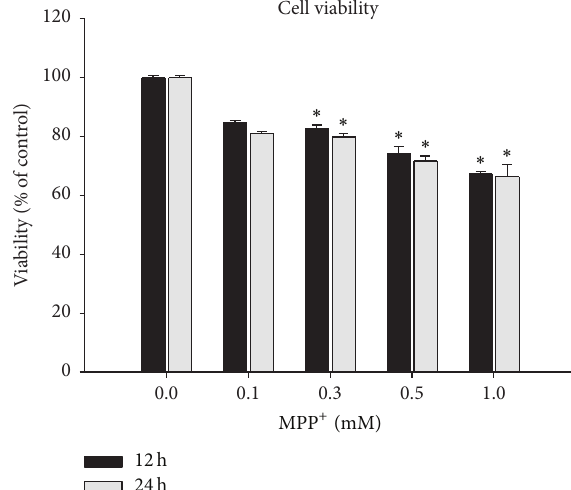
Figure 1: Comparisons of cell viability between control and MPP + - exposed BV-2 cells. MPP + was applied to the BV-2 cells at four concentrations (0.1 mM, 0.3 mM, 0.5 mM, and 1mM) and the incubation times were 12 hours and 24 hours . Note that there was no significant difference in cell viability between 0.1mM MPP + and control groups and there was a significant difference in cell viability between 0.3 mM MPP + and the control, between 0.5 mM MPP + and the control, and between 1mM MPP + and the control at 12 hours and 24 hours. ∗ 𝑃 < 0.05